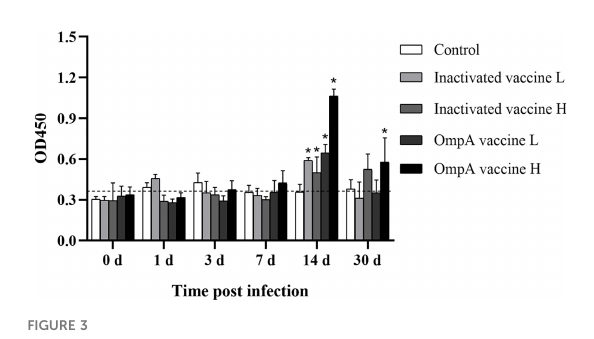
FIGURE 3 The speci fi c IgM levels to A. hydrophila detected by ELISA. Asterisk (*) indicated signi fi cant difference between the vaccinated groups and control group ( P < 0.05). The vertical cut-off line represented the control serum + 3×standard